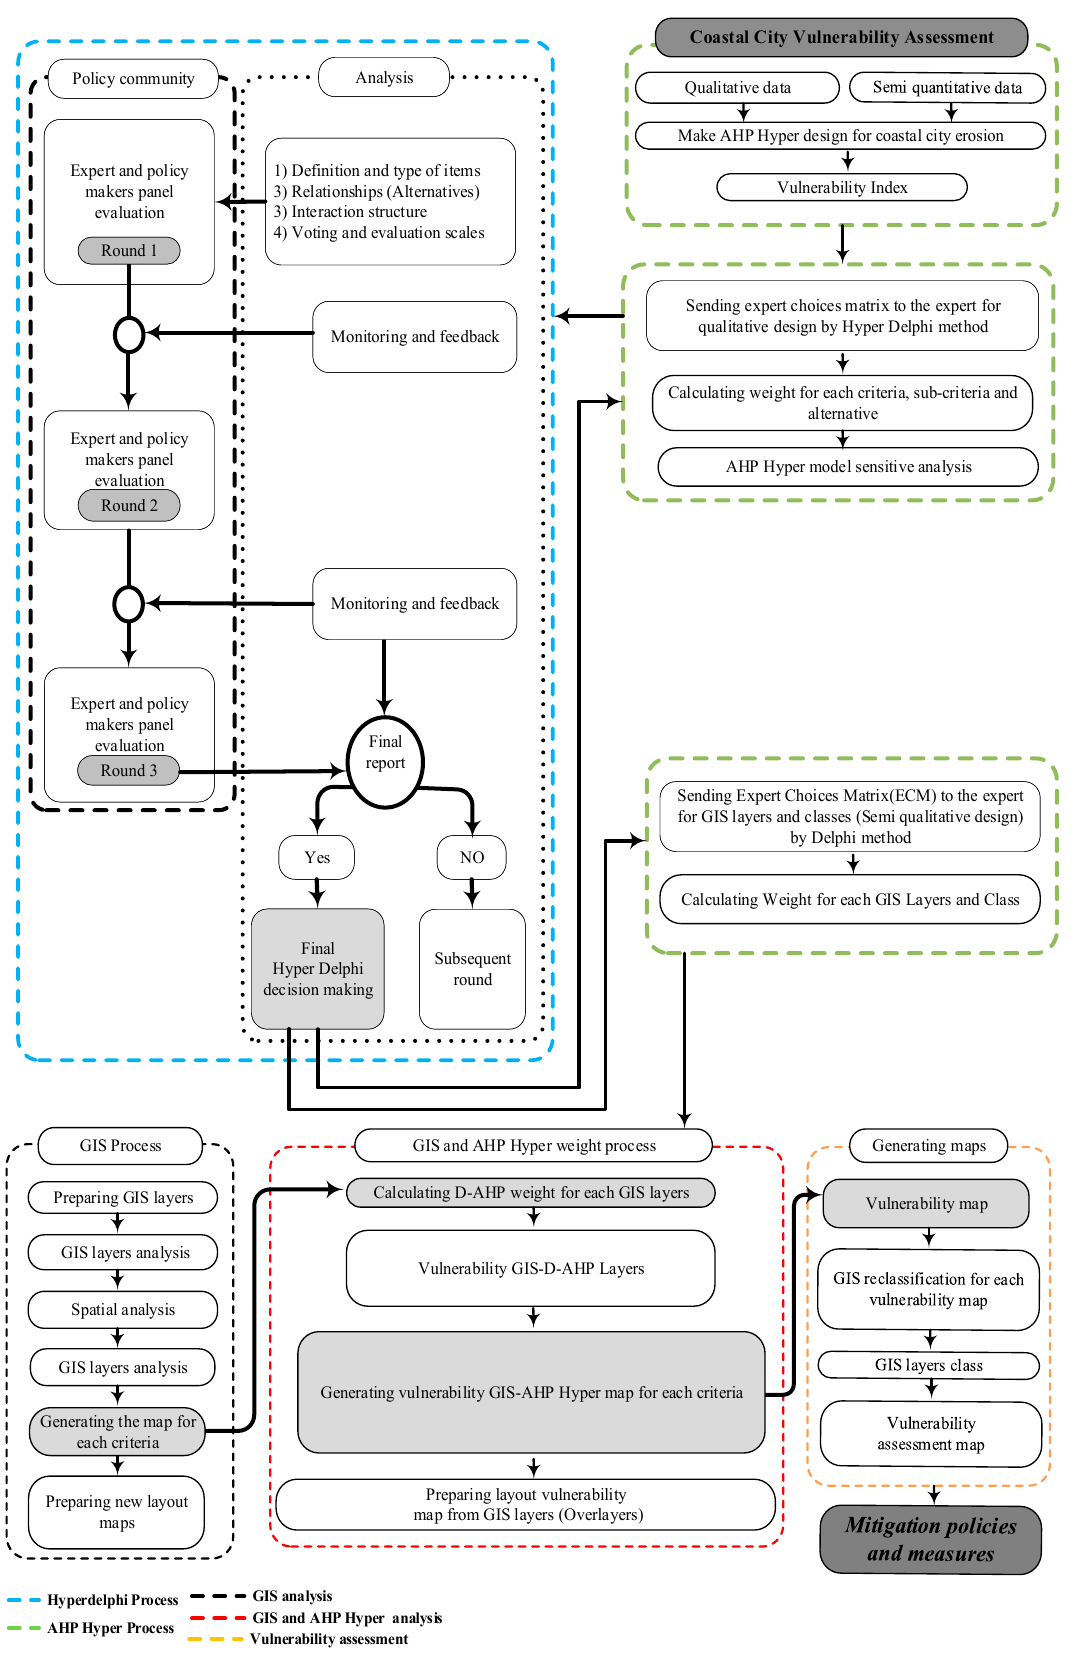
Figure 2. Coastal city vulnerability assessment and adaptation plan framework.